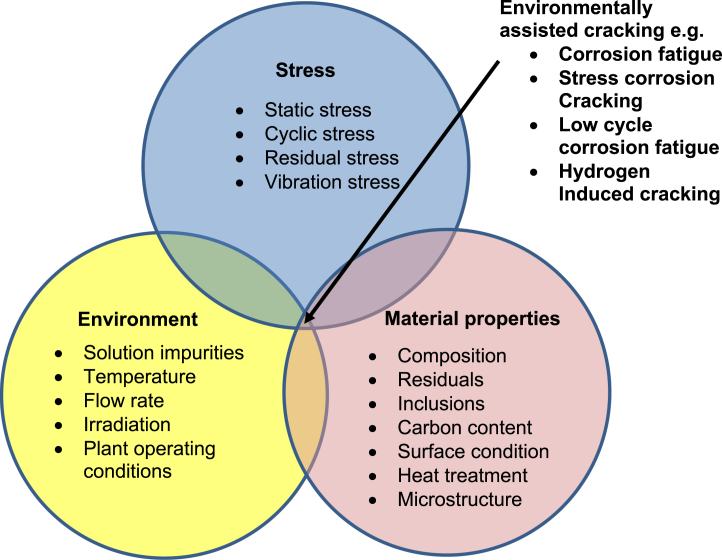
Venn diagram showing the main contributions to EAC1.